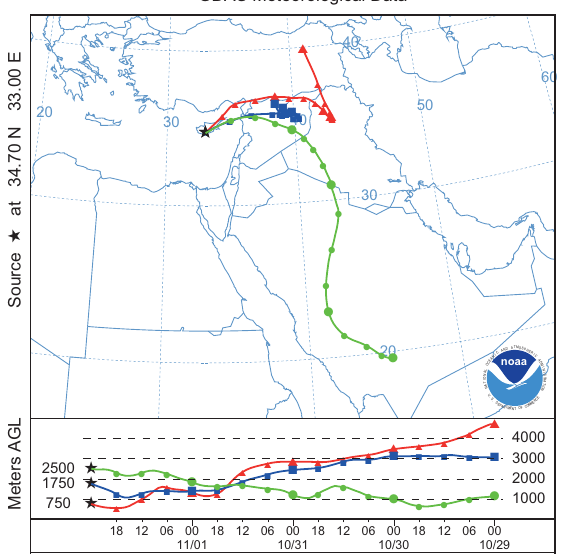
Figure 12. HYSPLIT 4-day backward trajectories arriving within the dust layer over Limassol, Cyprus, at 750 (red), 1750 (blue), and 2500m height (green) on 2 November 2013,